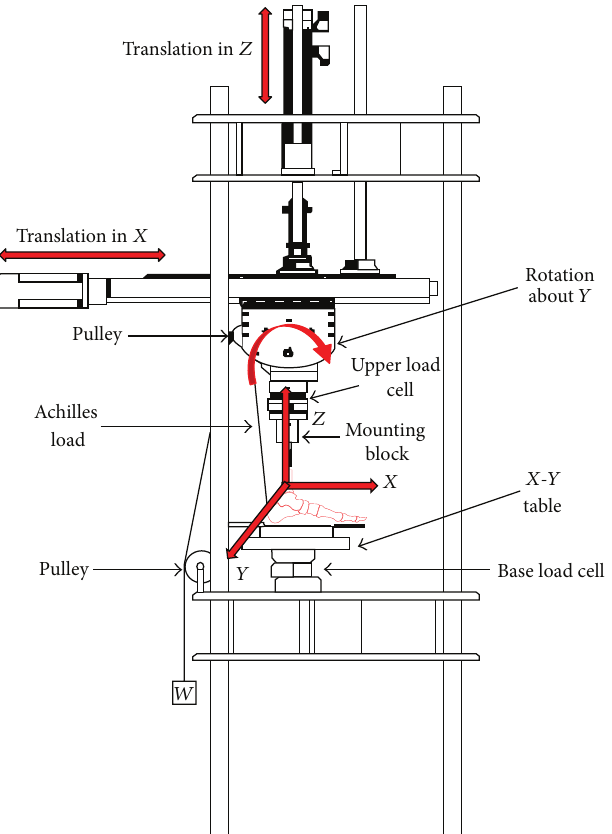
Figure2:Diagramofmultiaxisroboticsystemconfiguredfortheanklestudy[30].Thetestingplatformconsistedofanuppergimbalassembly with two translational and one rotational axes along with a 6-axis load cell, a mounting block to rigidly affix the specimen to the RTP, a pulley system to apply a static load to the AT, and an 𝑋 - 𝑌 table with a second 6-axis load cell to aid in the mounting procedure. The coordinate system is shown by 𝑥 -axis, 𝑦 -axis, and 𝑧 -axis. Translational and rotational vectors of the controlled axes of the RTP are also shown.